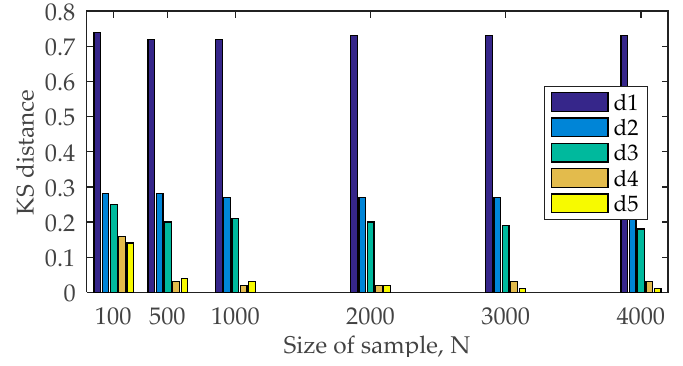
Figure 11 . Cumulated density functions 𝑭𝐗𝒊 | 𝑨 and 𝑭𝐗𝒊 | 𝑨 for each input 𝑿𝒊.